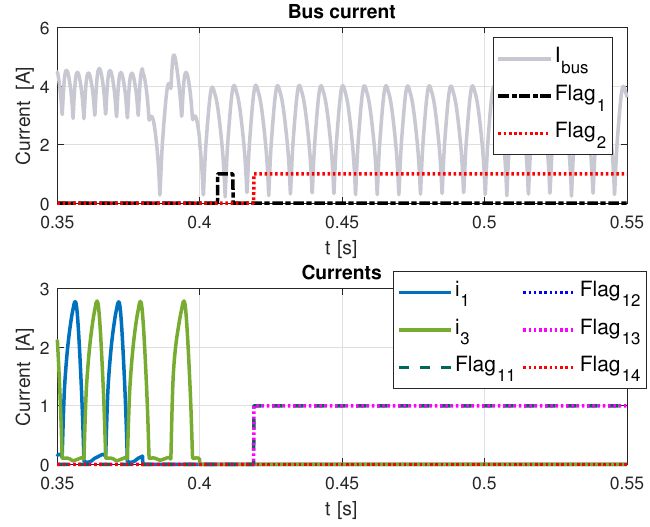
Figure 10. Two phases in fault, fault in phases 1 and 3.